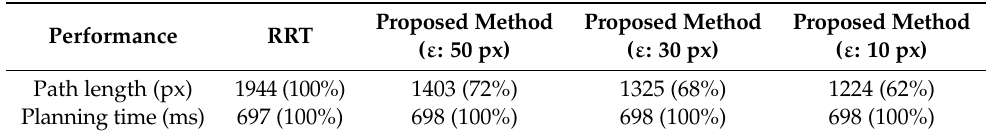
Table 2. Experimental results of Map 1 (numbers in parentheses (averages of repeating trial 100 times) are relative ratios to RRT results (values less than 1 are counted as